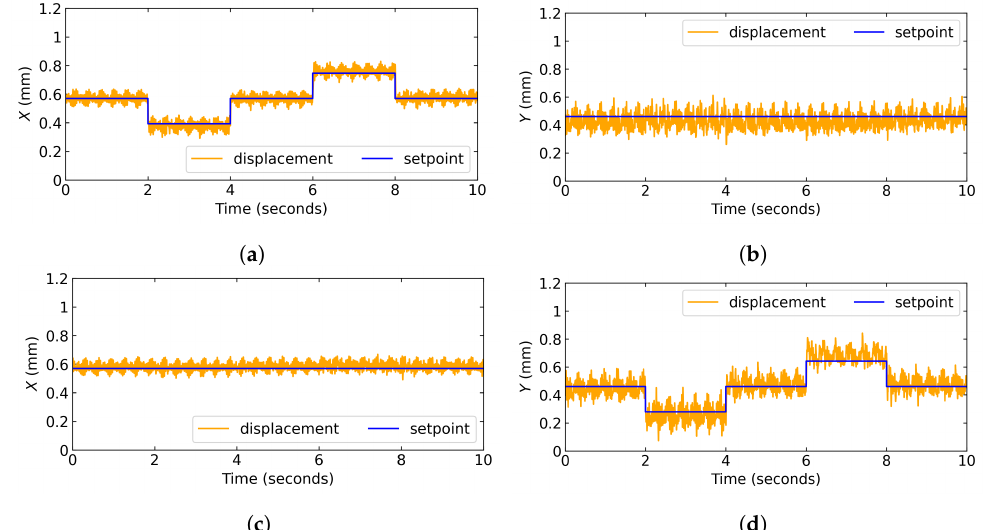
Figure 15. Response of radial position control under step setpoint changes for Linear ADRC. ( a ) X -axis behavior with step setpoint changes applied. ( b ) Y -axis behavior with step setpoint changes applied to X -axis. ( c ) X -axis behavior with step setpoint changes applied to Y -axis. ( d ) Y -axis behavior with step setpoint changes